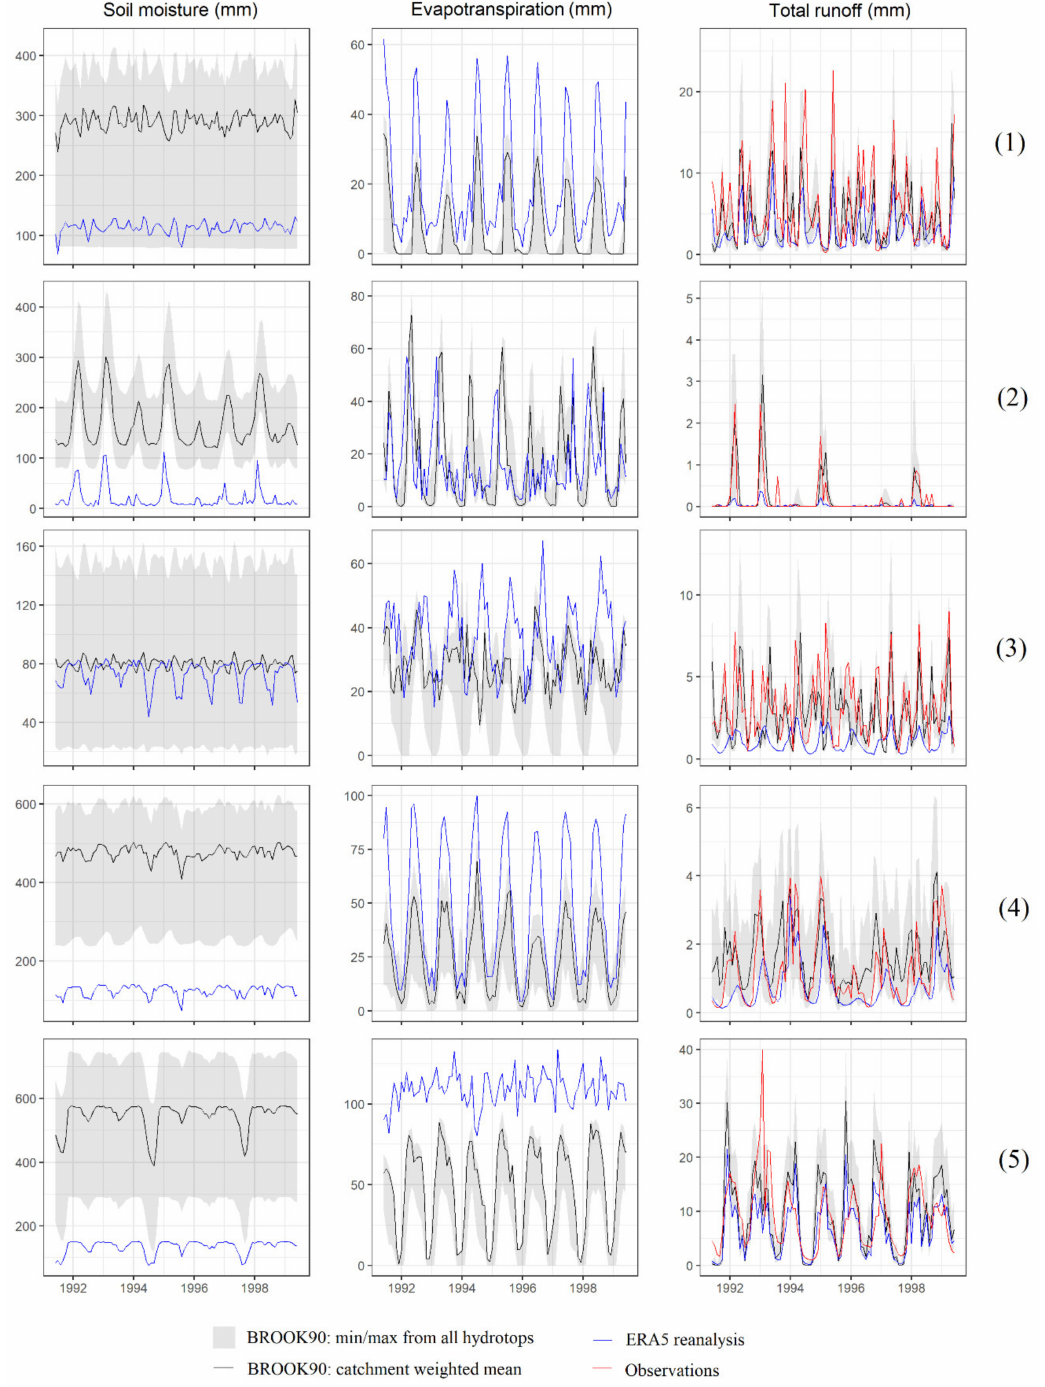
Figure 5. Monthly time-series of modeled (weighted mean and maximum / minimum range from all hydrotopes) soil water content, evapotranspiration, and runo ff (overlapped with observation line) for the chosen catchments (numbers on the right side refer to Table